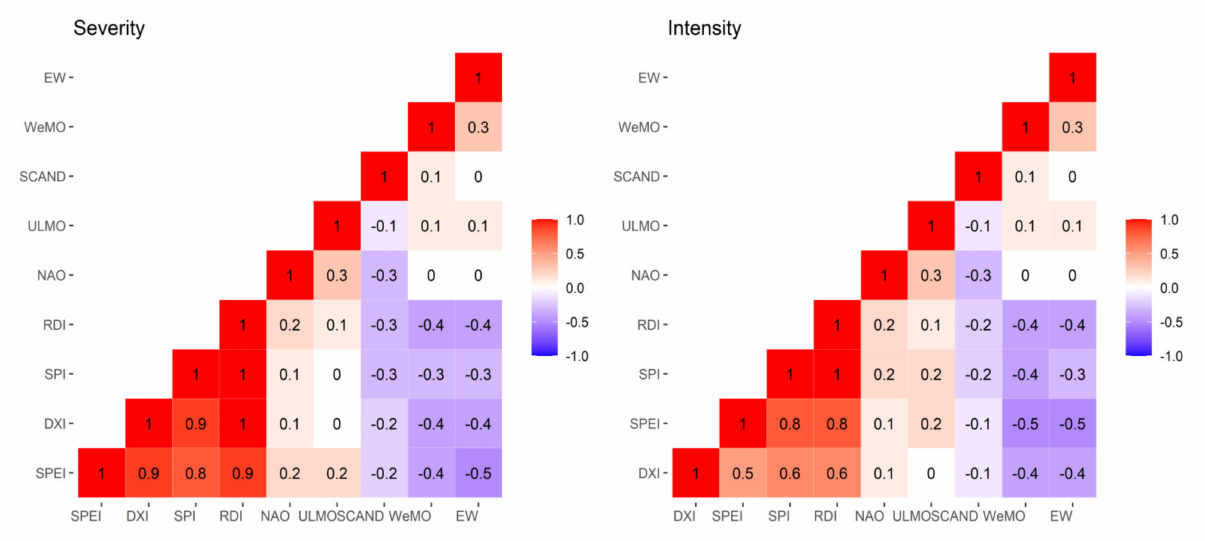
Figure 9. Values of the matrix correlation of drought severity and intensity identified by SPI-12, SPEI-12, RDI-12 and DXI-12, and the ATPs over the MED. (Values greater than or equal to the absolute value of 0.3 are